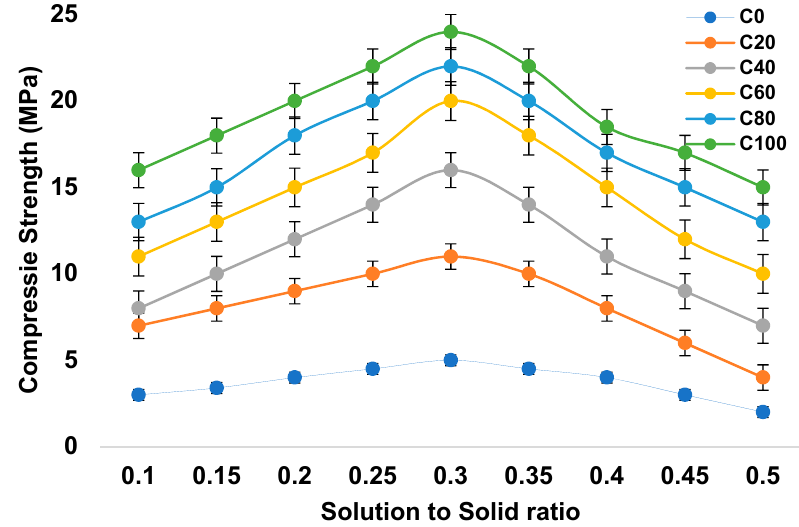
Figure 5. Effect of solution to solid ratio on the compressive strength of geopolymer.